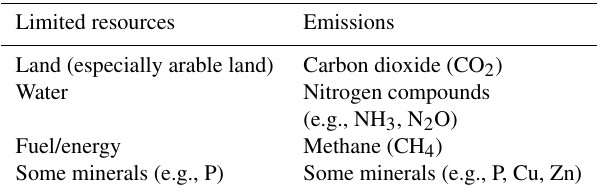
Table 1. Limited resources and emissions in the production of food of animal